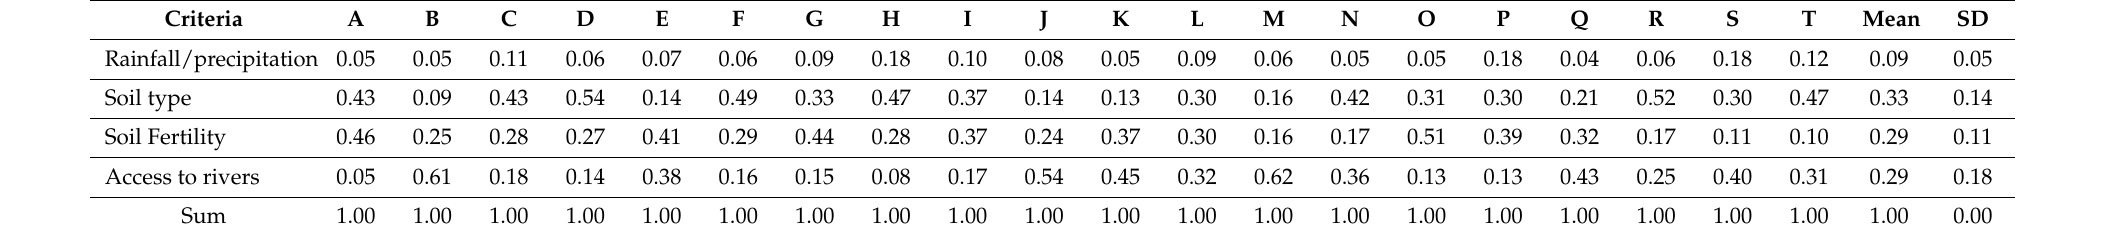
Table 6. Weights of the criteria for agricultural areas suitability mapping using AHP.